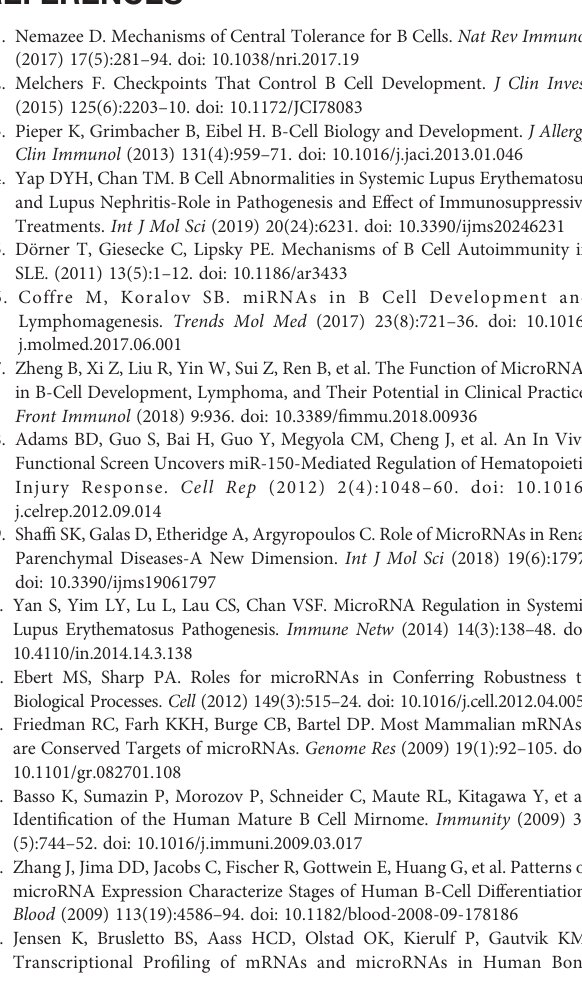
Marrow Precursor B Cells Identi fi es Subset- and Age-Speci fi c Variations. PloS One (2013) 8(7):e70721. doi: